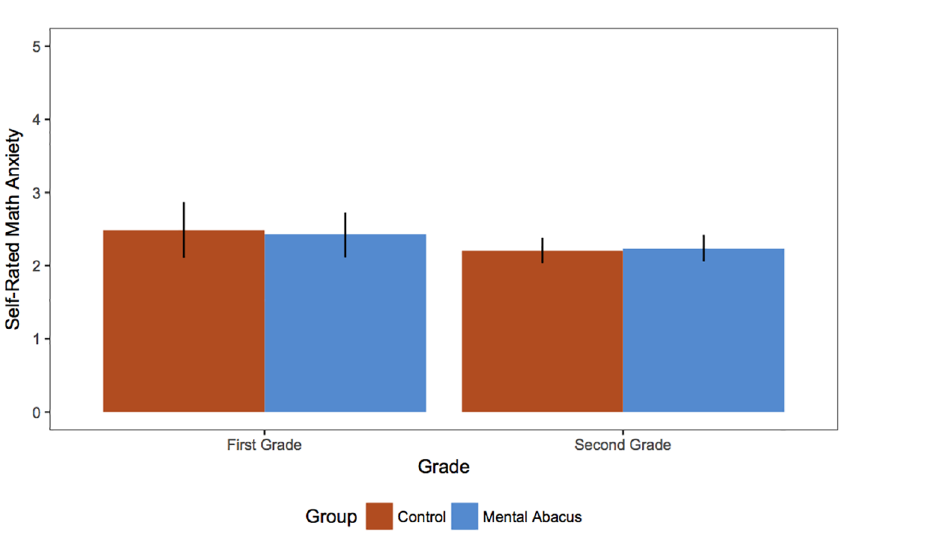
Figure 8. Average math anxiety ratings (on a five-point Likert scale), split by group and grade level. Error bars show 95% confidence intervals computed by non-parametric